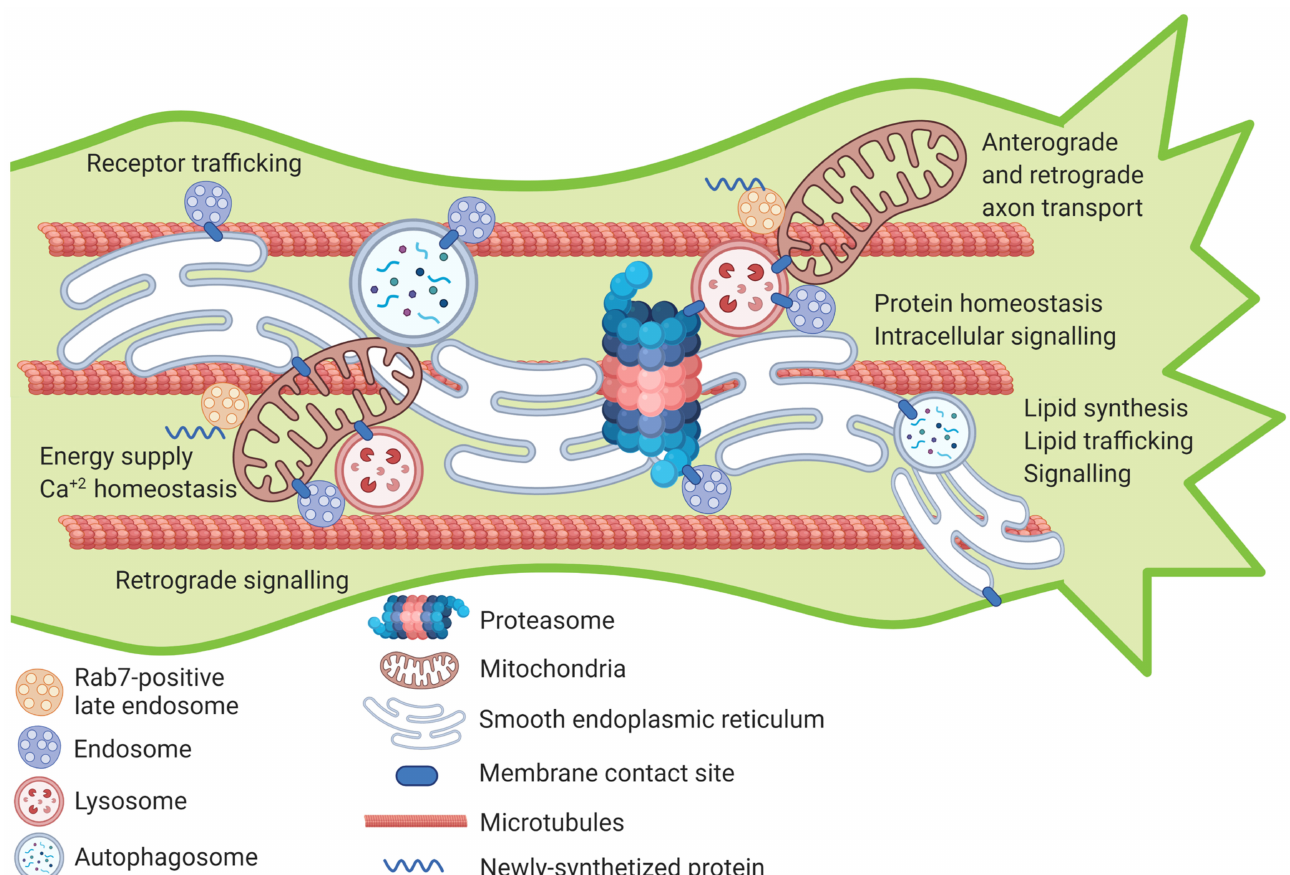
Figure 1. Proposed model for inter-organellar interactions within the axon shaft. Within the cell, various organelles form transient or permanent interactions with each other. Many of these organellar inter-connections have previously been documented in the axon (such as ER-mitochondria, ER-lysosome, ER-endosome, mitochondria-lysosome) but some are yet to be studied. This model proposes that membrane-contact sites between pairs of organelles or multiple organelles could occur in the axon shaft near the growth cone of developing or regenerating axons. These interactions play an essential role in numerous processes involved in axon growth and regeneration such as lipid signaling and trafficking, protein turnover, intracellular signaling, calcium buffering, receptor trafficking and energy homeostasis. Future studies on the developmental regulation of the quantity and dynamics of inter-organelle membrane contact sites could provide clues on how they can be targeted to boost axon growth and regeneration. Figure created with BioRender.com (www.biorender.com [last accesses 18 January